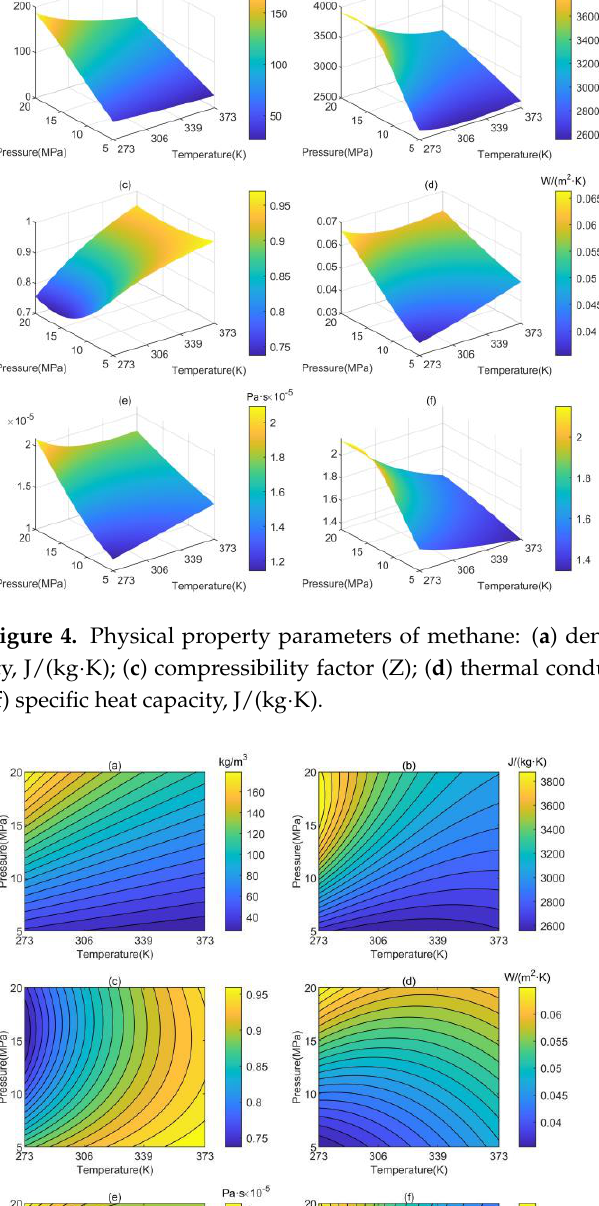
Figure 6. Physical property parameters of carbon dioxide: ( a ) density, kg/m 3 ; ( b ) isobaric heat ca- pacity, J/(kg·K); ( c ) compressibility factor (Z); ( d ) thermal conductivity, W/(m·K); ( e ) viscosity, Pa·s; ( f ) specific heat capacity, J/(kg·K).